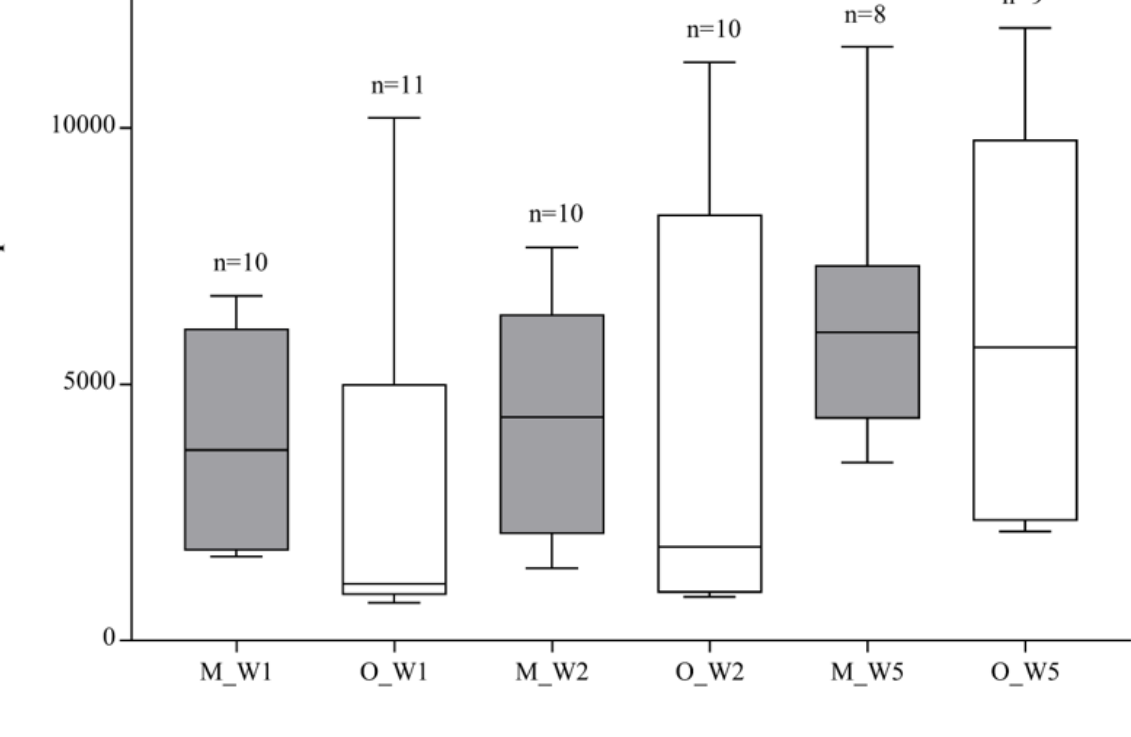
Figure 4. Boxplots of weekly average number of steps in robotically assisted minimally invasive direct coronary artery bypass (RA-MIDCAB) and off-pump coronary artery bypass (OPCAB) patients. Weekly average step counts is shown as box and whisker plots, presenting medians, 25% and 75% quartiles, minimums, and maximums. n indicates the number of patients included in the cohort result. M_W1: MIDCAB result in week 1; O_W1: OPCAB results in week 1; M_W2: MIDCAB results in week 2; O_W2: OPCAB results in week 2; M_W5: MIDCAB results in week 5; O_W5: OPCAB results in week 5.